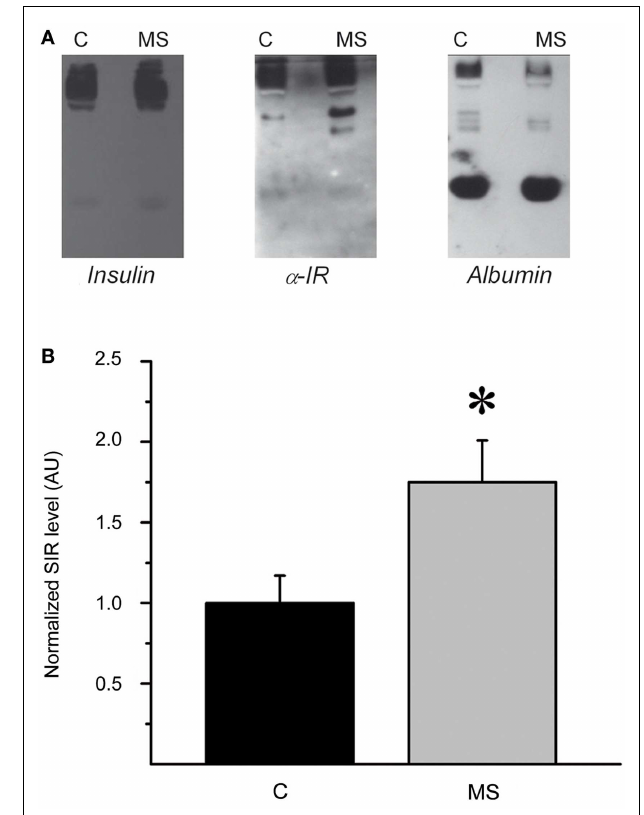
FIGURE 7 | Plasma SIR is increased in MS rats . (A) Western blots of native gel electrophoresis from representative plasma samples from control (C) and metabolic syndrome (MS) rats that show co-migration of insulin, SIR, and albumin in rat plasma as indicated by the colocalization of all molecules.The intensity and size of insulin and SIR bands are higher in MS rats than controls. (B) Comparison of normalized plasma SIR levels determined by densitometry ofWestern blot bands. Bars represent mean ± SEM of control (C) and MS rats, * p < 0.05 and ** p < 0.01.